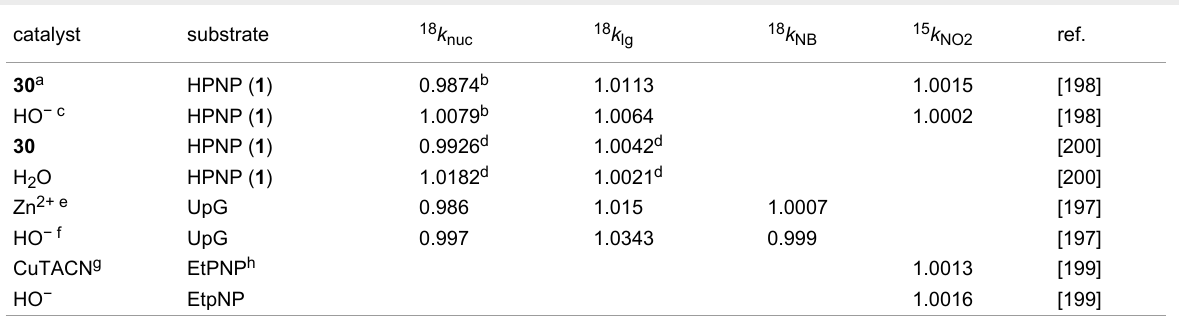
Table 6: Heavy-isotope effects determined in the presence and absence of metal ion catalysts.